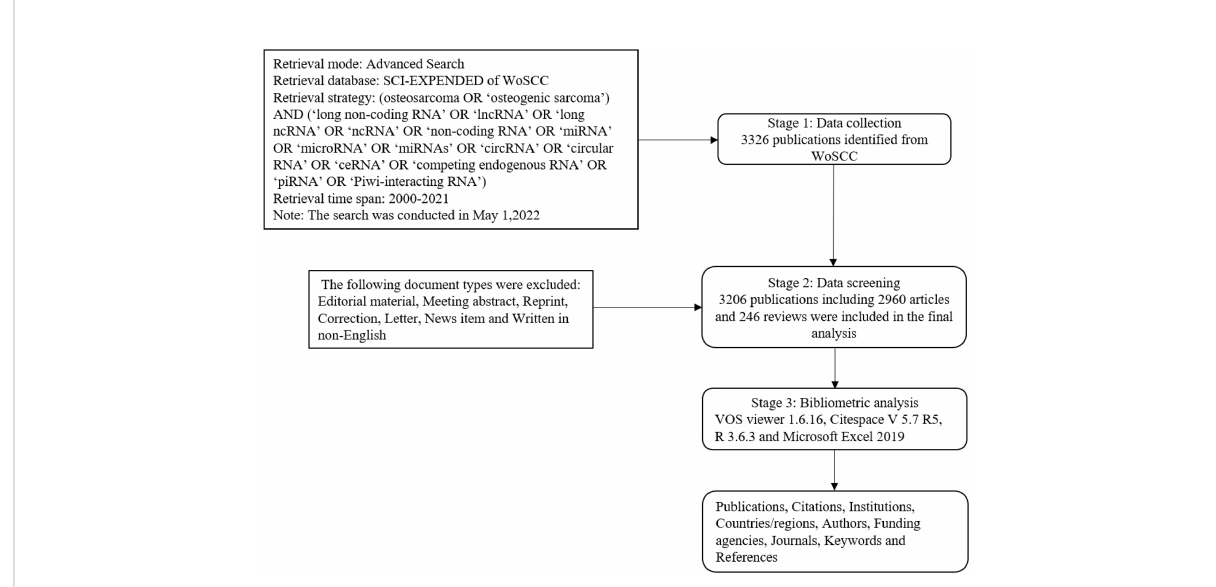
FIGURE 1 Flow diagram of the literature search and selection